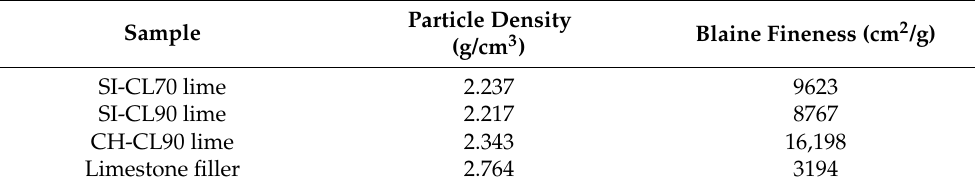
Table 3. Particle density and specific surface area of hydrated limes and limestone filler. Particle Density Sample (g/cm 3